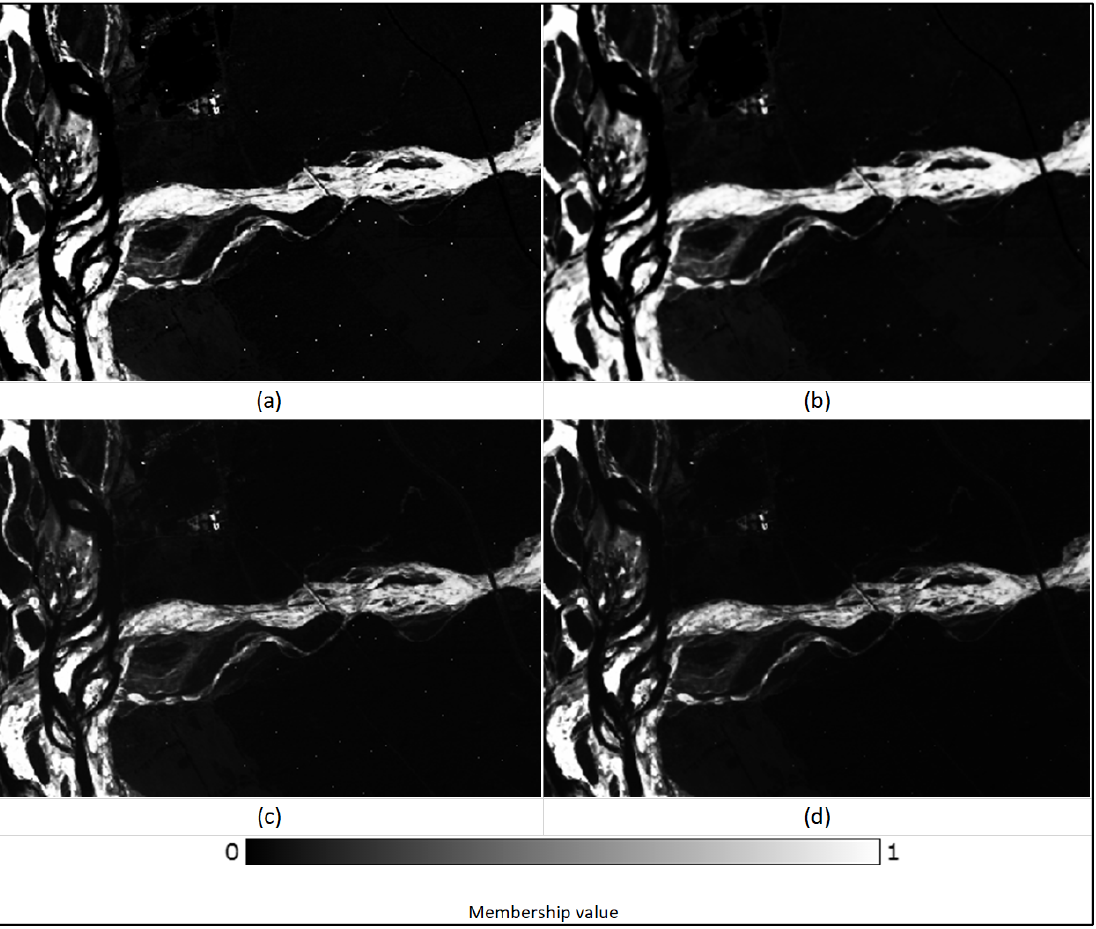
Figure 21. The membership fraction image for the ‘Riverine Sand’ class generated by ( a ) FCM, ( b ) FCM-S, ( c ) PCM, and ( d ) PCM-S algorithms.